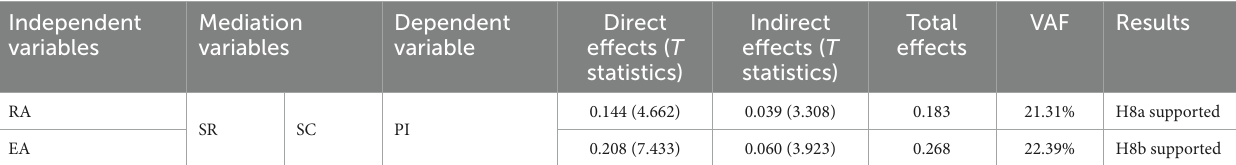
TABLE 7 Analysis results of chain mediation